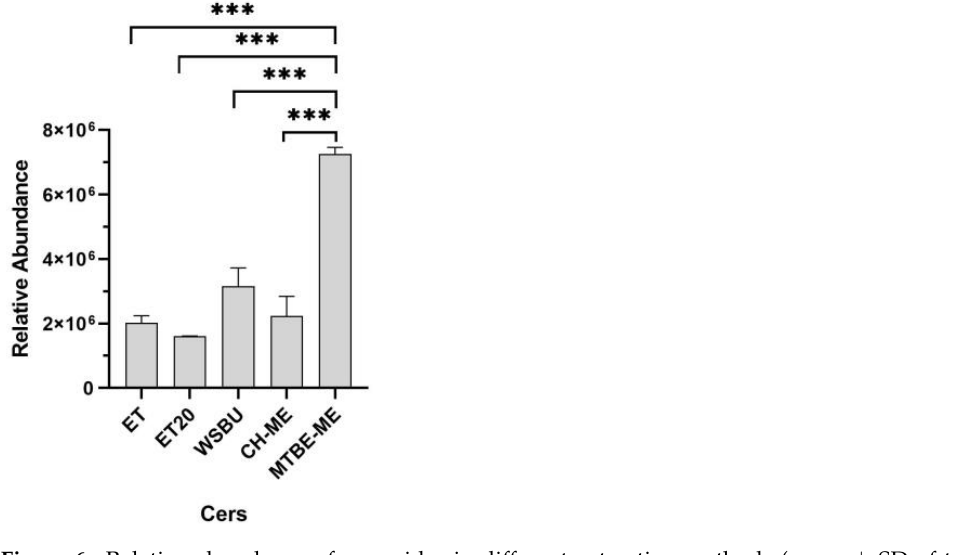
Figure 6. Relative abundance of ceramides in different extraction methods (mean ± SD of two replicates, *** = p -value < 0.001).